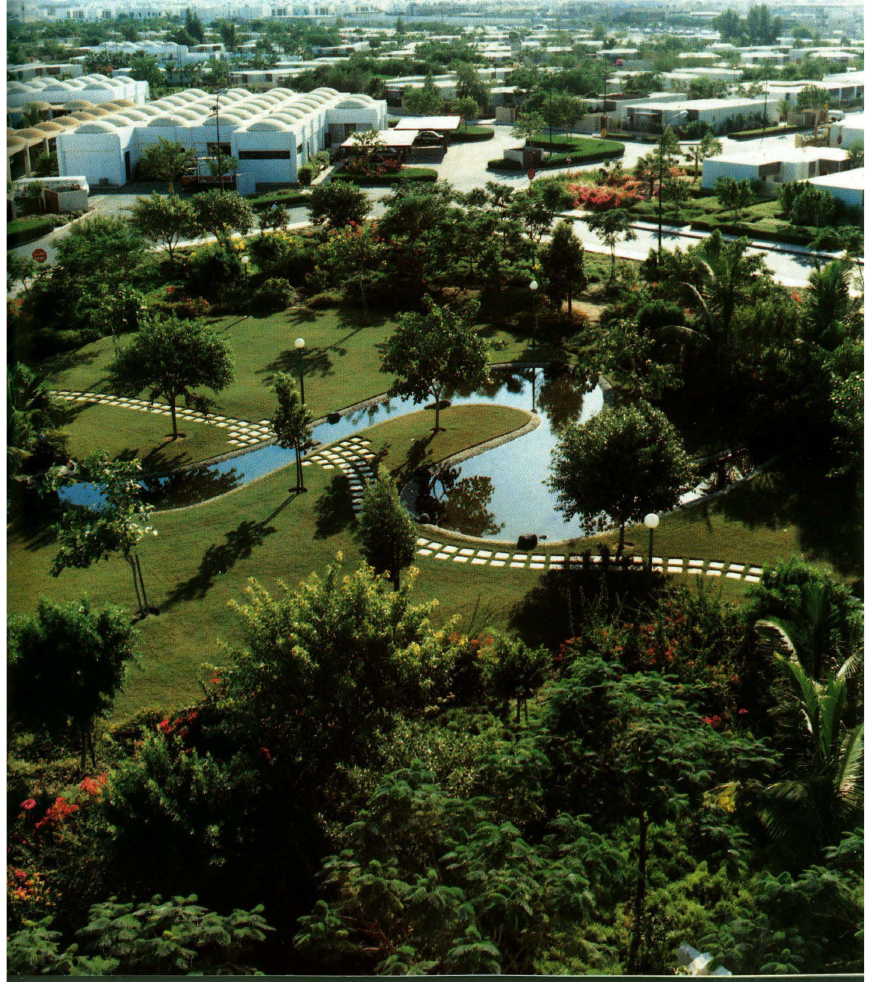
Fig. 5 Landscaping laced the cities with greenery, which flourished due to desalination plants and petrochemicals. Source: The Royal Commission for Jubail and Yanbu, 10 Years of Accom-plishments (Riyadh: the Royal Commission,